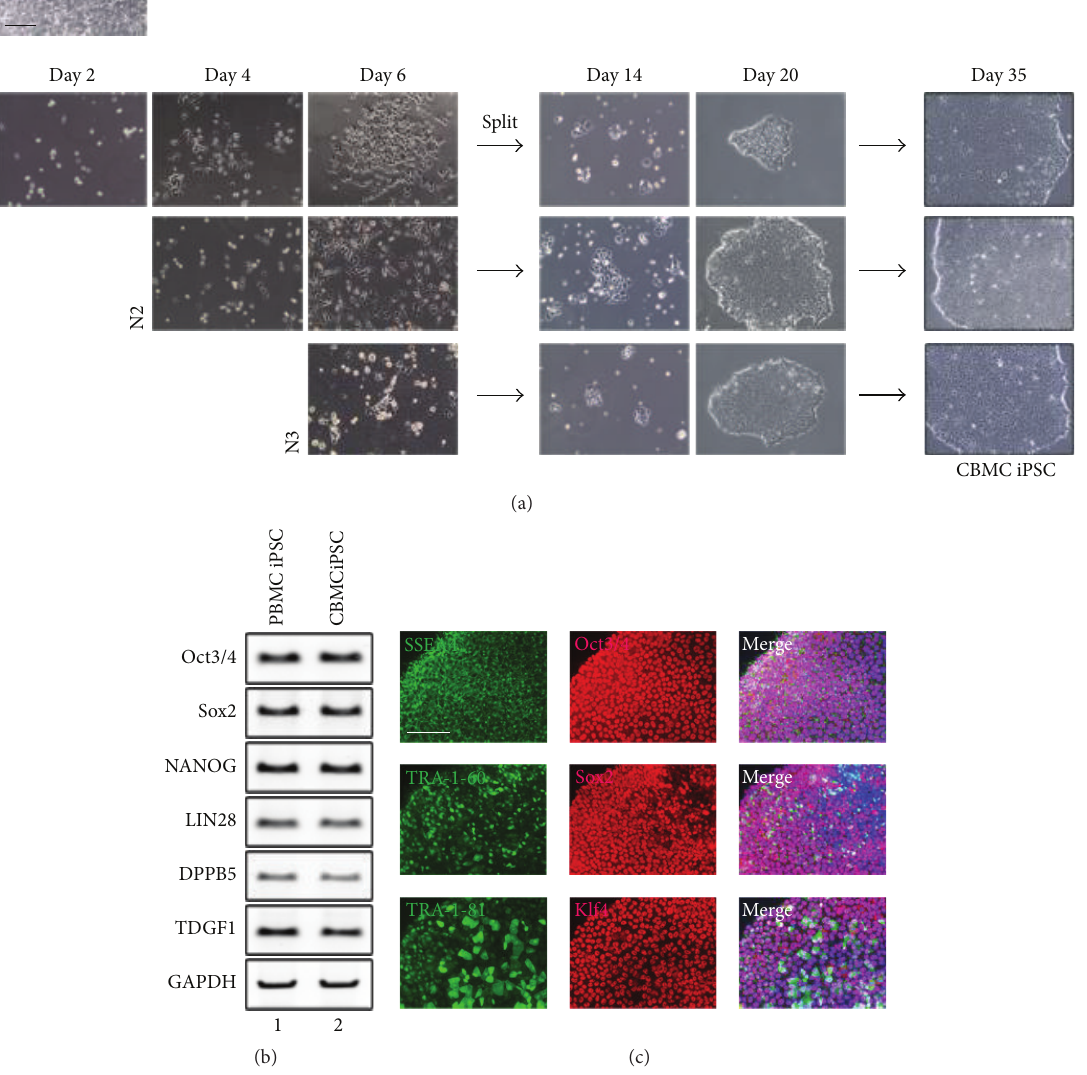
Figure 4: Generation of iPSCs from CBMCs with the established protocol. (a) Brightfield image of iPSCs generated from CBMCs. Colonies appeared in a similar time frame as PBMC iPSCs. (b) Gene expression of pluripotency markers in N3 from CBMC iPSCs showed similar expression to that of PBMC iPSC N3. (c) Immunocytochemical staining of CBMC iPSC clone N3. Scale bars: 200 𝜇